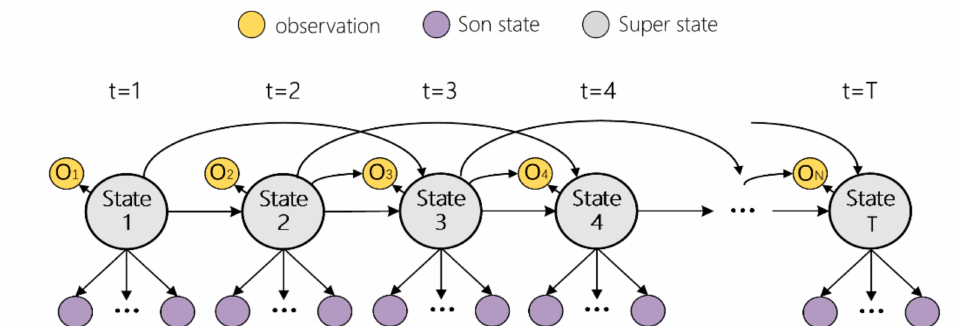
Figure 1. The illustration of two-order HSMM.